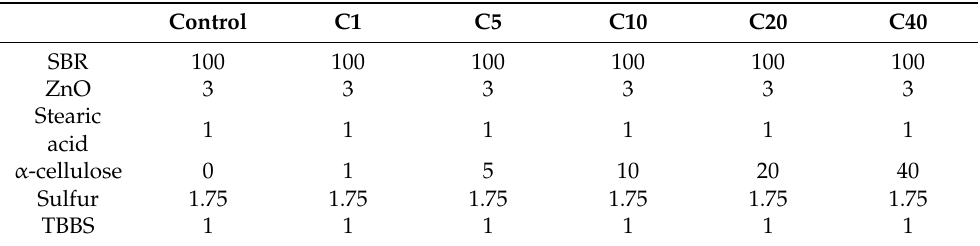
Table 1. Formulation (in phr) used for α -cellulose-E-SBR composite. Here ‘phr’ stands for parts per hundred of